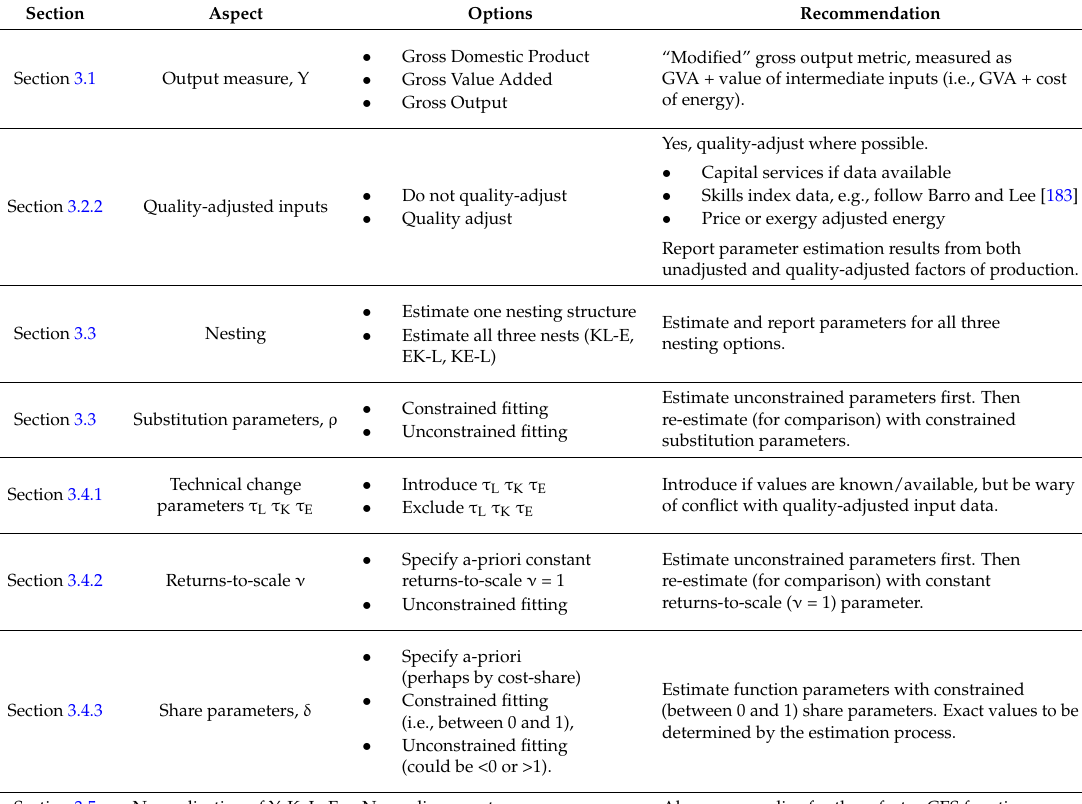
Table 2. Specification recommendations for energy-extended CES aggregate production